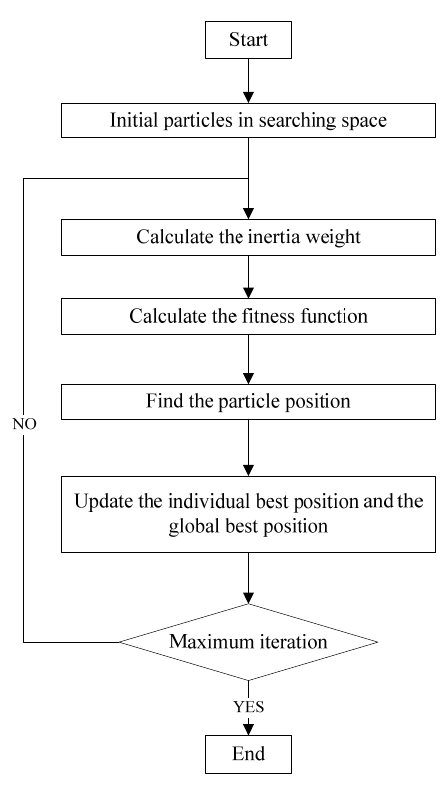
Figure 4. Flow chart of PSO